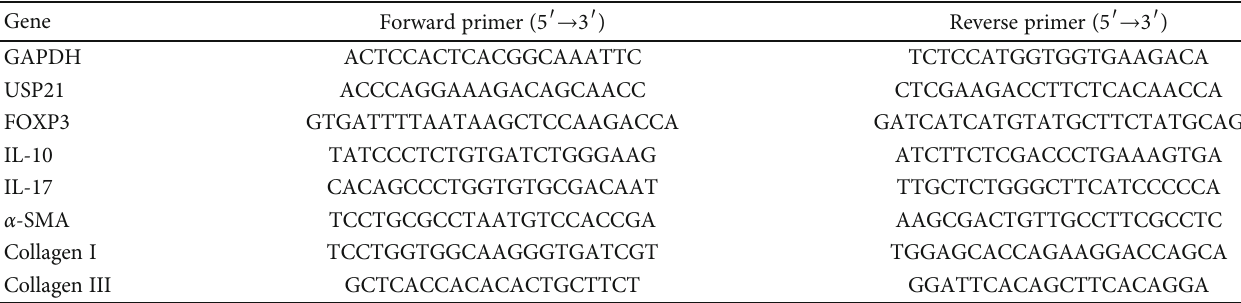
Table 1: Primers used for the mRNA